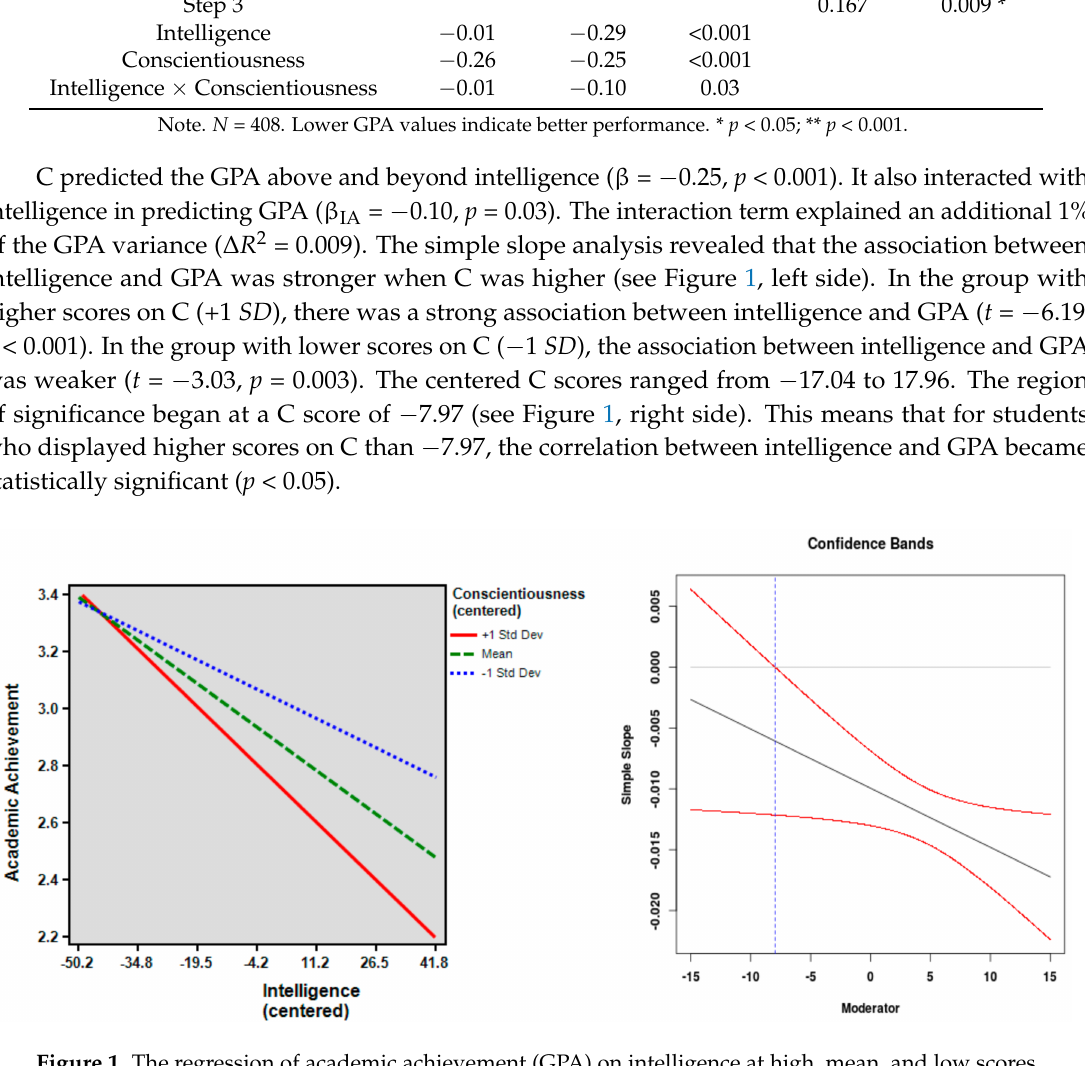
Figure 1. The regression of academic achievement (GPA) on intelligence at high, mean, and low scores on Conscientiousness (on the left ) as well as confidence bands and region of significance (on the right ). The dotted line marks the score of the moderator at which the association between GPA and intelligence becomes statistically significant ( p <